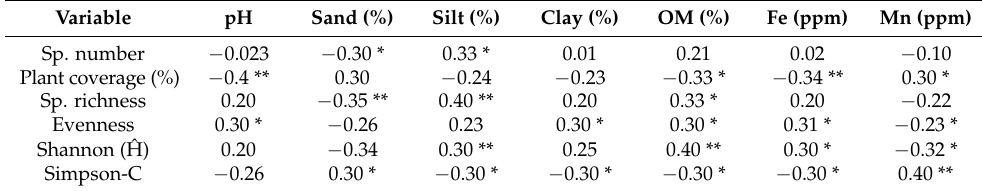
Table 3. Pearson’s correlation coefficients between calculated diversity indices and different physical and chemical soil characteristics in the study